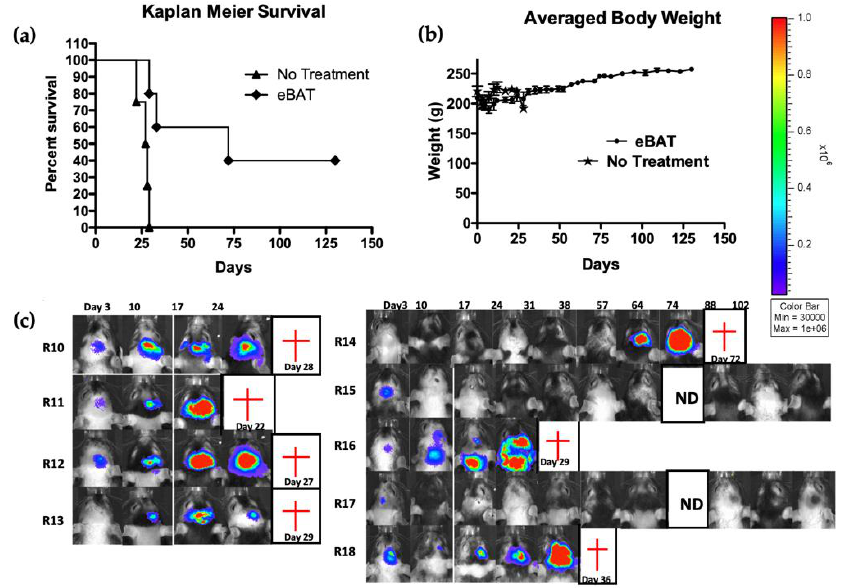
Figure 3. In vivo intracranial tumor experiment showing that eBAT had potent anti-glioma e ff ects [41]. Athymic nude rats were U87-luc cells intracranially on Day 0. On Days 7 and 14, a group of rats was either left untreated or treated with 2 mg eBAT delivered via convection-enhanced delivery (CED), using a hollow fiber (HF) catheter. Drug was delivered stereotactically at the same coordinates as tumor. Each animal was subjected to weekly imaging to monitor tumor growth. ( a ) Kaplan–Meier curve comparing the treated versus the untreated groups. ( b ) Animal Weight. Average weight in